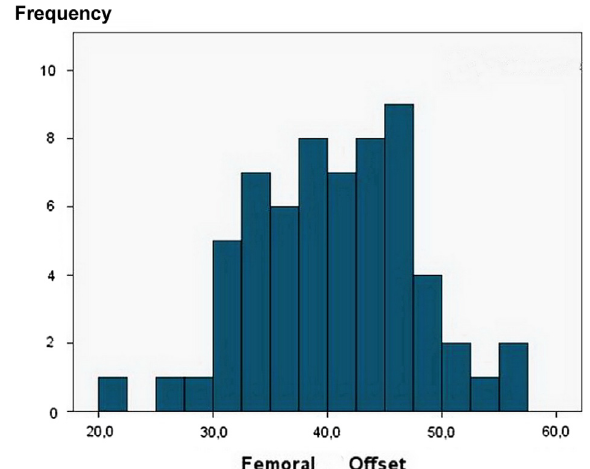
Figure 6. Distribution histogram showing femoral offset in